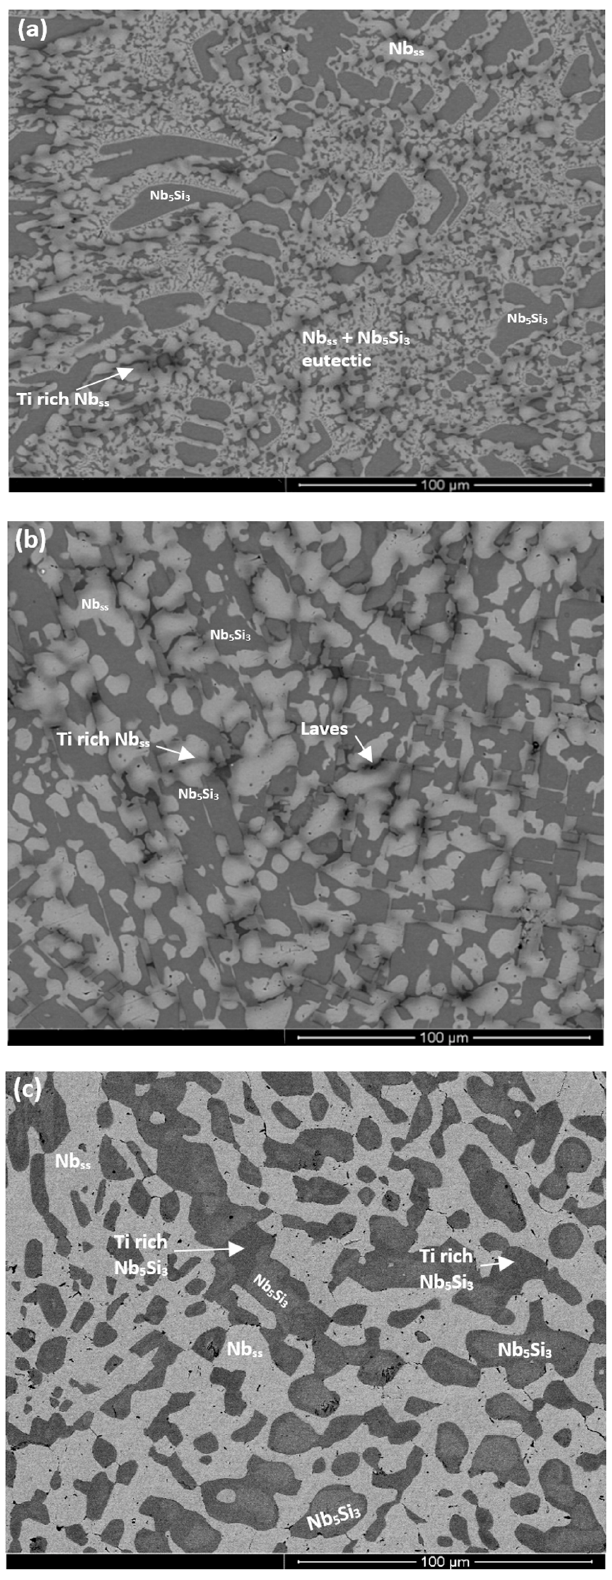
Figure 1. Back-scatter electron (BSE) images of the microstructure of the cast ( a ) bulk and ( b ) bottom of the button of the alloy ZX3 and ( c ) bulk of the heat-treated alloy.